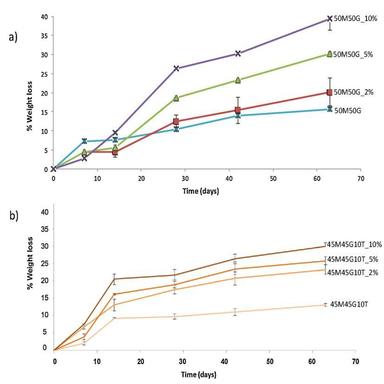
Mass loss due to hydrolytic degradation of: a)50M50G and b)45M45G10T coatings.